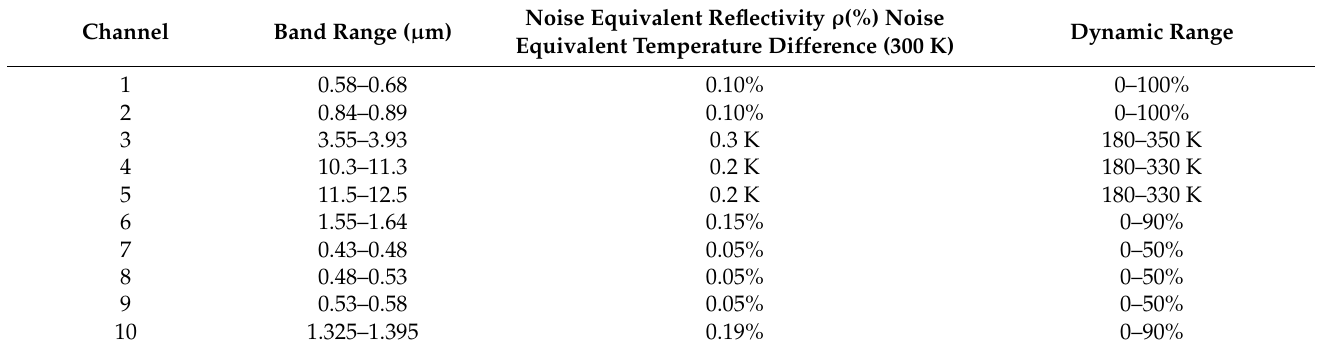
Table 1. FY-3C/VIRR spectrum specifications